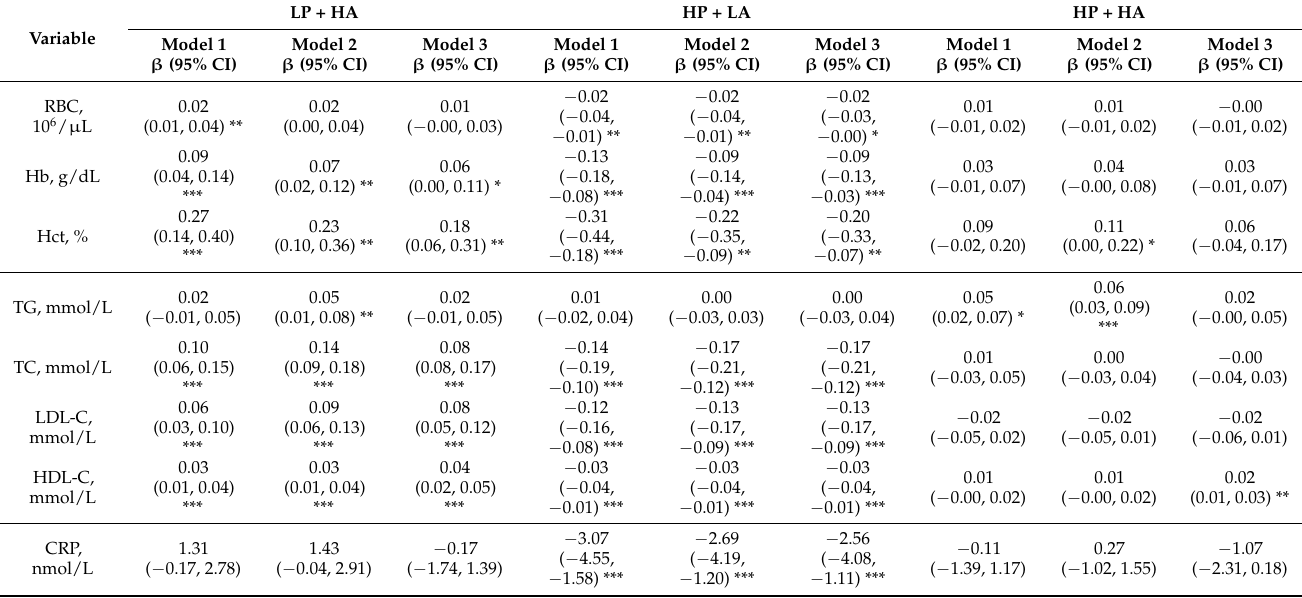
Table 4. Association between dietary patterns and biochemical variables among dyslipidemic women aged 20–45 years ( n = 22,631) in